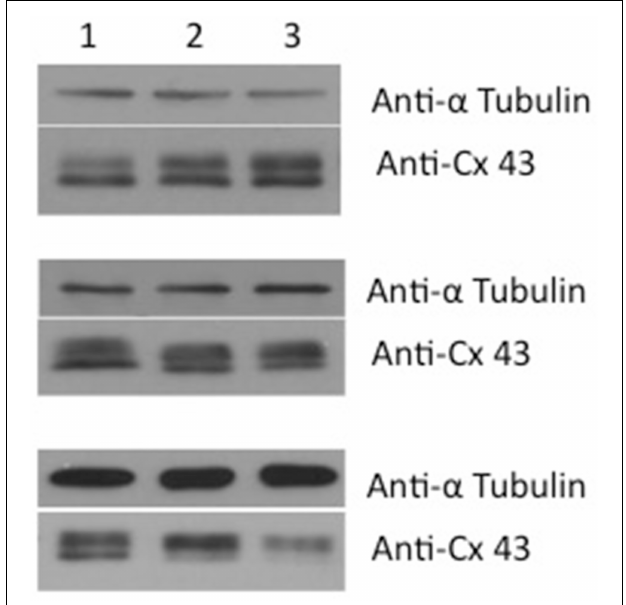
FIGURE 1 | Western blot of corpora cavernosa smooth muscle cells. The western blot shows the effect of 4PB after 48h exposure at concentrations of 0 (lane 1), 1mM (lane 2), and 5mM (lane 3). The reporter protein used was tubulin along with Cx43. Three examples are shown. From top to bottom – increased expression, no change and reduced expression. The average value for six Western blots using ImageJ analysis was 0.93 ± 0.25 SD of controls.